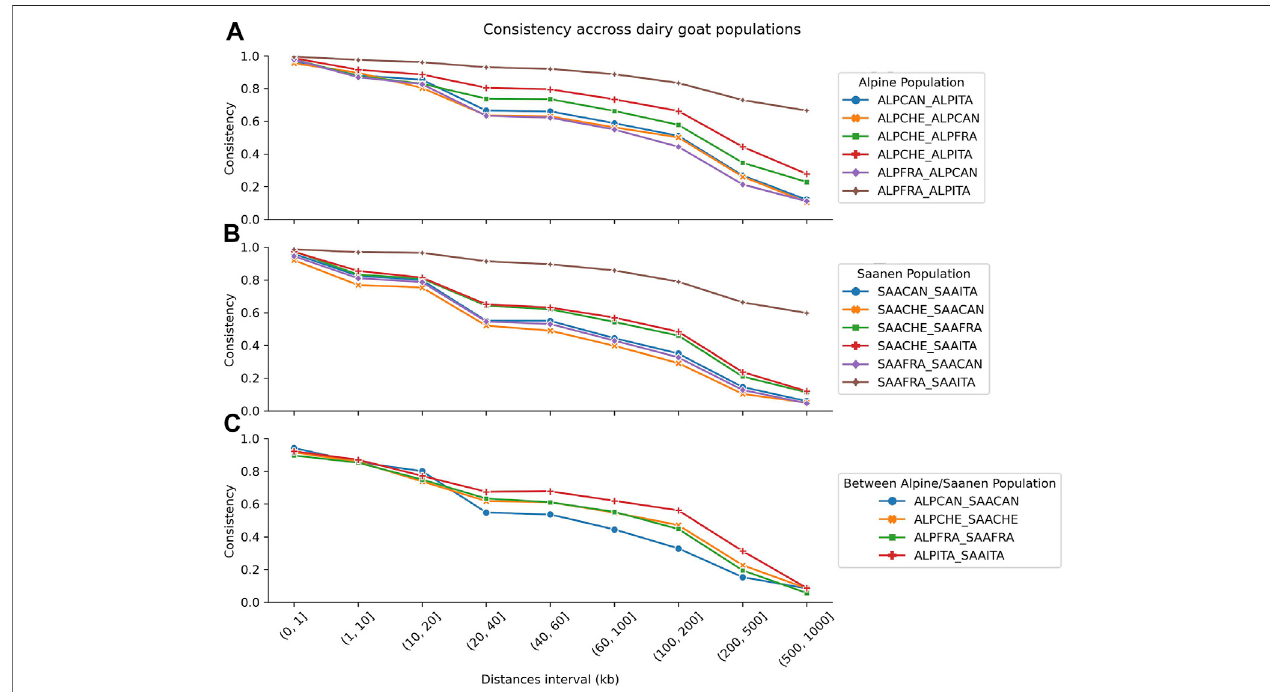
FIGURE 3 | Comparison of the consistency of the gametic phase for nine classes of distances between SNPs with comparison between Alpine populations (A) , Saanen populations (B) , and Alpine and Saanen from the same country (C) . Breeds are represented by Alpine (ALP) and Saanen (SAA), whilecountries are represented by Canada (CAN), Switzerland (CHE), France (FRA), and Italy